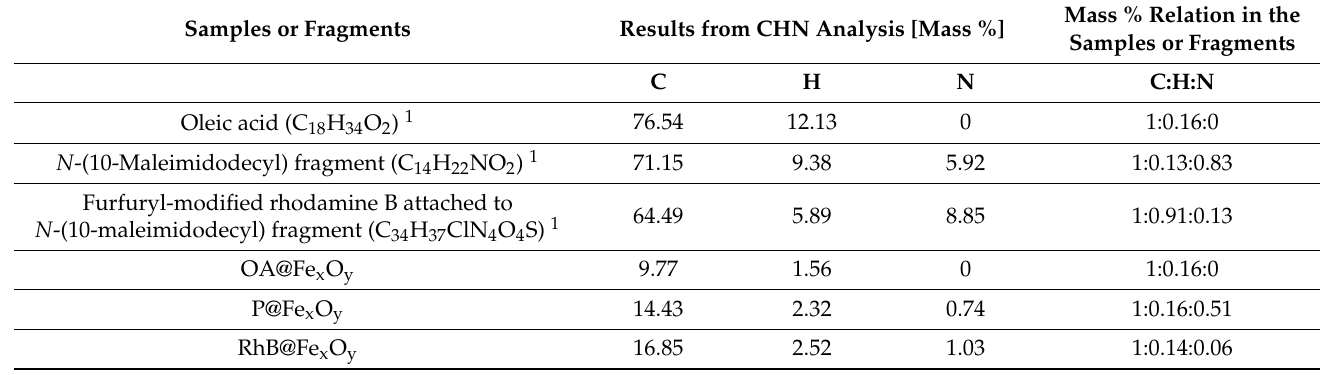
Table 1. Results from elemental analysis of the samples compared with theoretical calculated values of fragments attached to the surface of the iron oxide particles. Mass % Relation in the Samples or Fragments Results from CHN Analysis [Mass %] Samples or Fragments C C:H:N Oleic acid (C 18 H 34 O 2 ) 1 N -(10-Maleimidodecyl) fragment (C 14 H 22 NO 2 ) 1 Furfuryl-modified rhodamine B attached